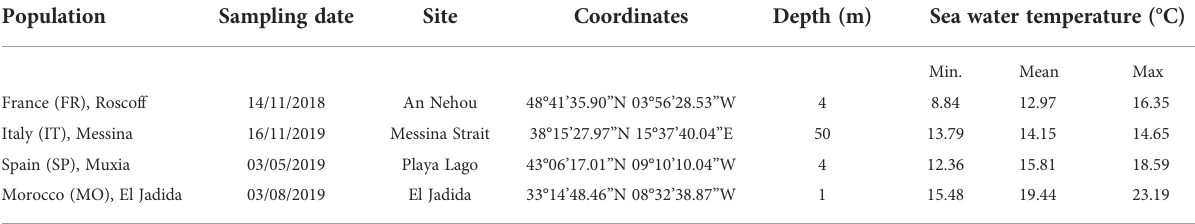
TABLE 1 Locations of Laminaria ochroleuca sampling sites (country, sampling date, geographical coordinates of each site, depth). Population